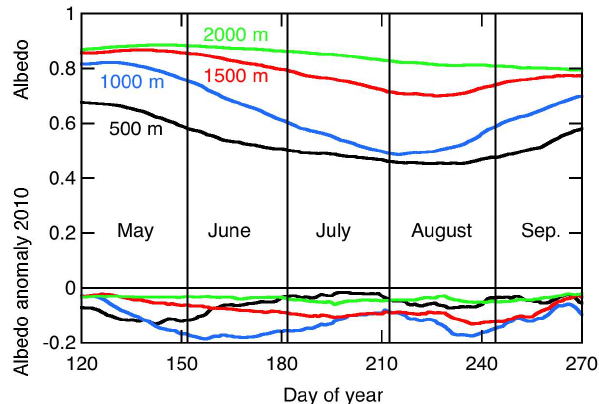
Fig. 4. Thirty-day running mean (calibrated) albedo at 500m (black), 1000m (blue), 1500m (red) and 2000m (green) elevation above sea level for the MODIS period (2000–2010). The lower lines give the 2010 albedo anomaly with identical colour